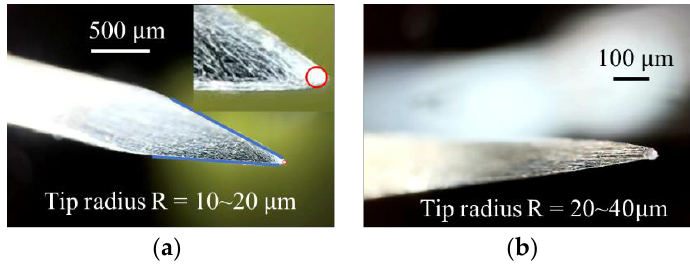
Figure 2. The structure of the spine. ( a ) Before wear. ( b ) After wear.